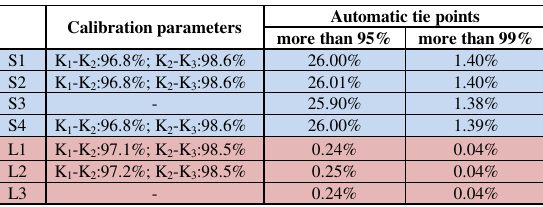
Table 4. Correlations in the processed projects in DBAT. For the automatic points, the value denotes the percentage of automatic tie points with high correlation